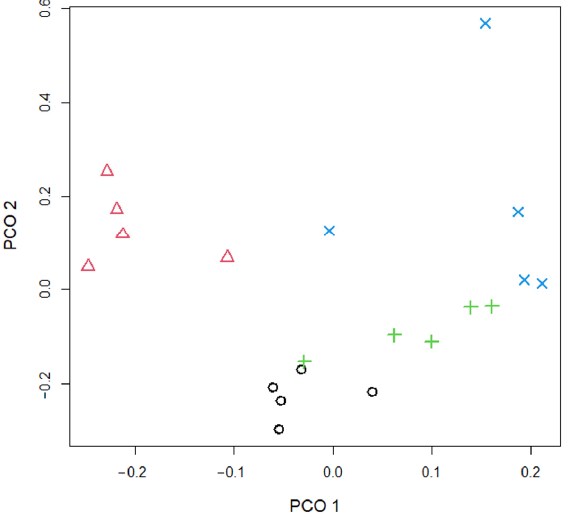
Figure 6. PCoA plot of the twenty host trees at the four sites ( ○ Lake, ∆ Lee, + Wind, and × WindN). Epiphyte assemblage affinity was analyzed using the abundance data (Hellinger ‐ transformed) of 31 holo ‐ epiphyte species on each host tree.